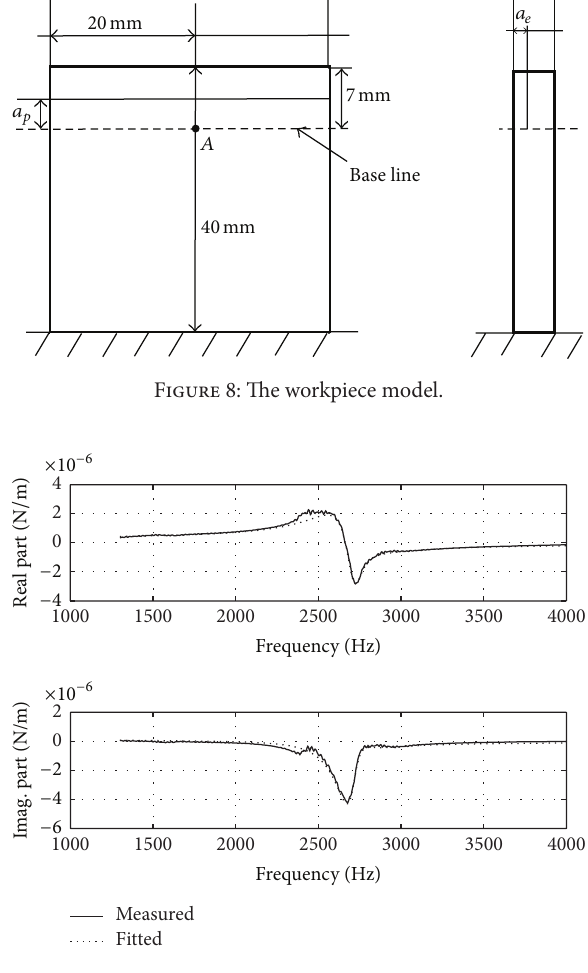
Figure 9: Frequency response function of